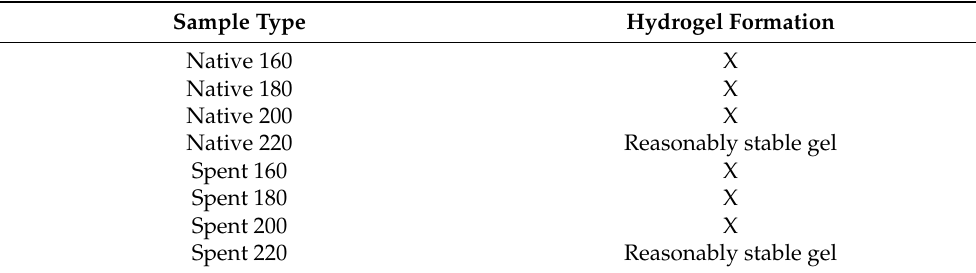
Table 1. Hydrogel formation results of defibrillated cellulose samples with numbers corresponding to the temperature in ◦ C of the microwave process in the preparation step of the